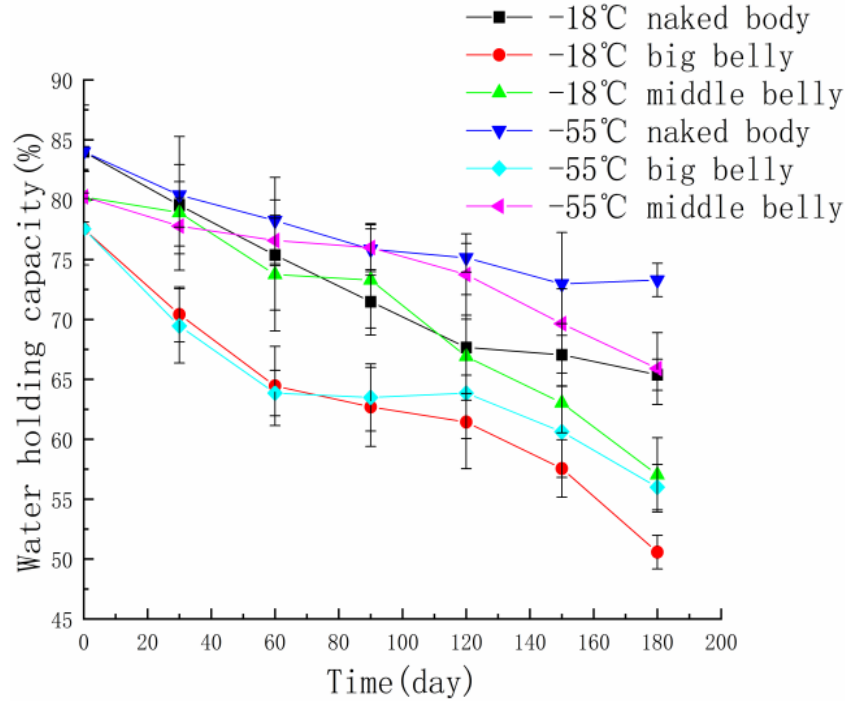
Figure 1. The change in water-holding capacity in different parts of tuna during frozen storage at different temperatures.